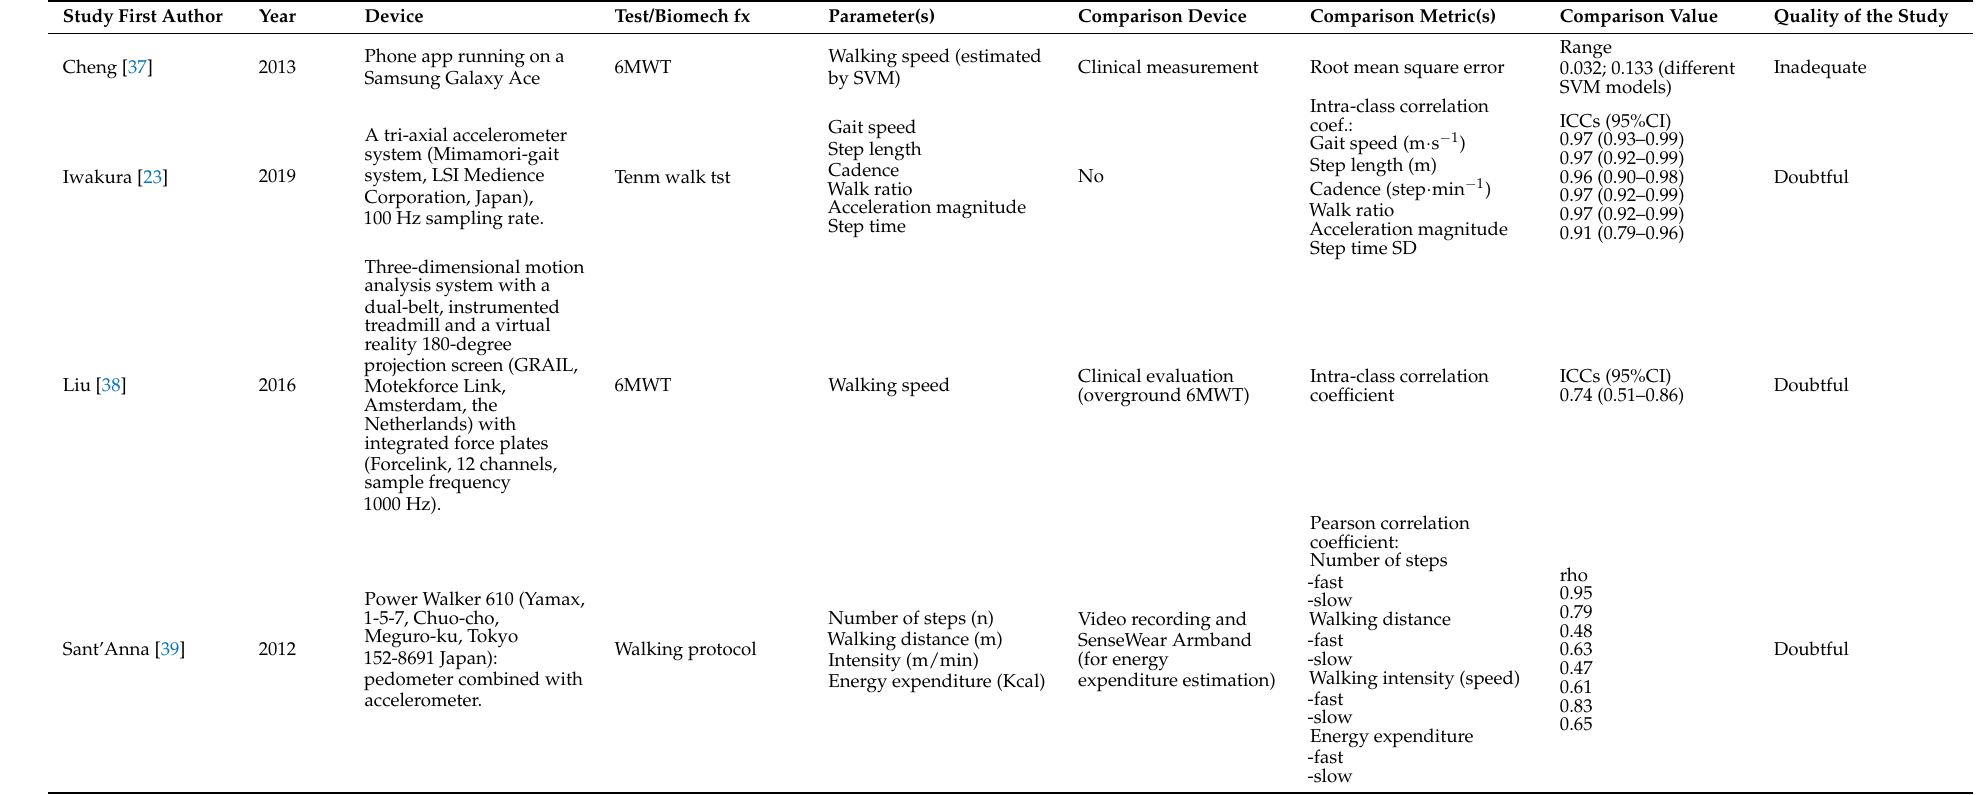
Table 5. Devices employed, function(s) evaluated, parameters retrieved, and comparison metric(s) used in validation